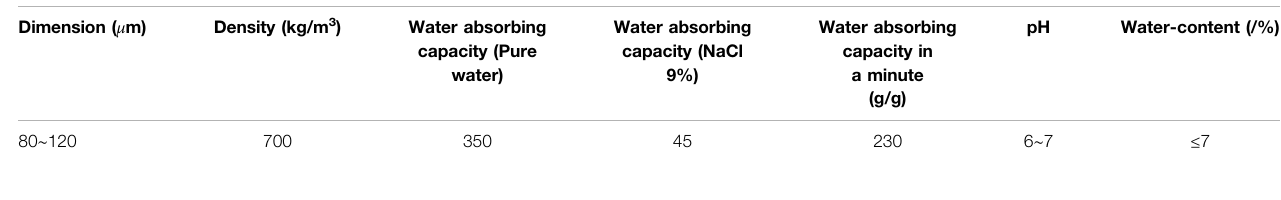
TABLE 2 | Properties of internal curing agent